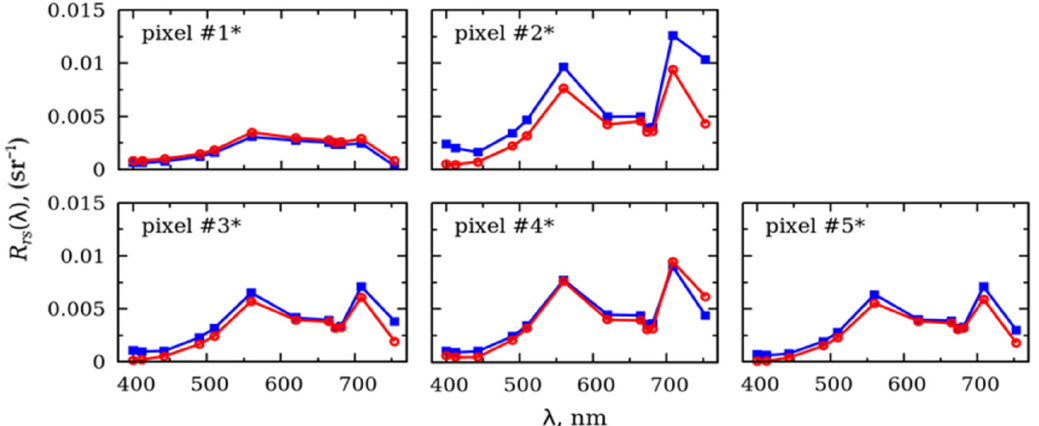
Figure 7. Time variation of averaged R rs spectra at the same point of the reservoir after time delay stated in Table 2. The blue lines correspond to earlier measurements and the red lines to later ones. Pixel numbers are given in left upper corner and correspond to Figure Table 3. Temporal variability of the concentration of Chl a in the Gorky Reservoir in pixels on Fig- ure 5d.